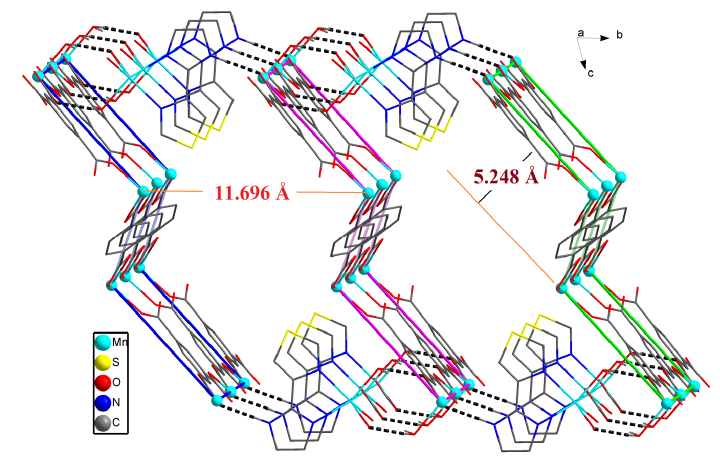
Figure 10. The three-dimensional architecture of the crystal via H-bonding (hydrogen bonds: yellow). Unnecessary atoms are omitted for